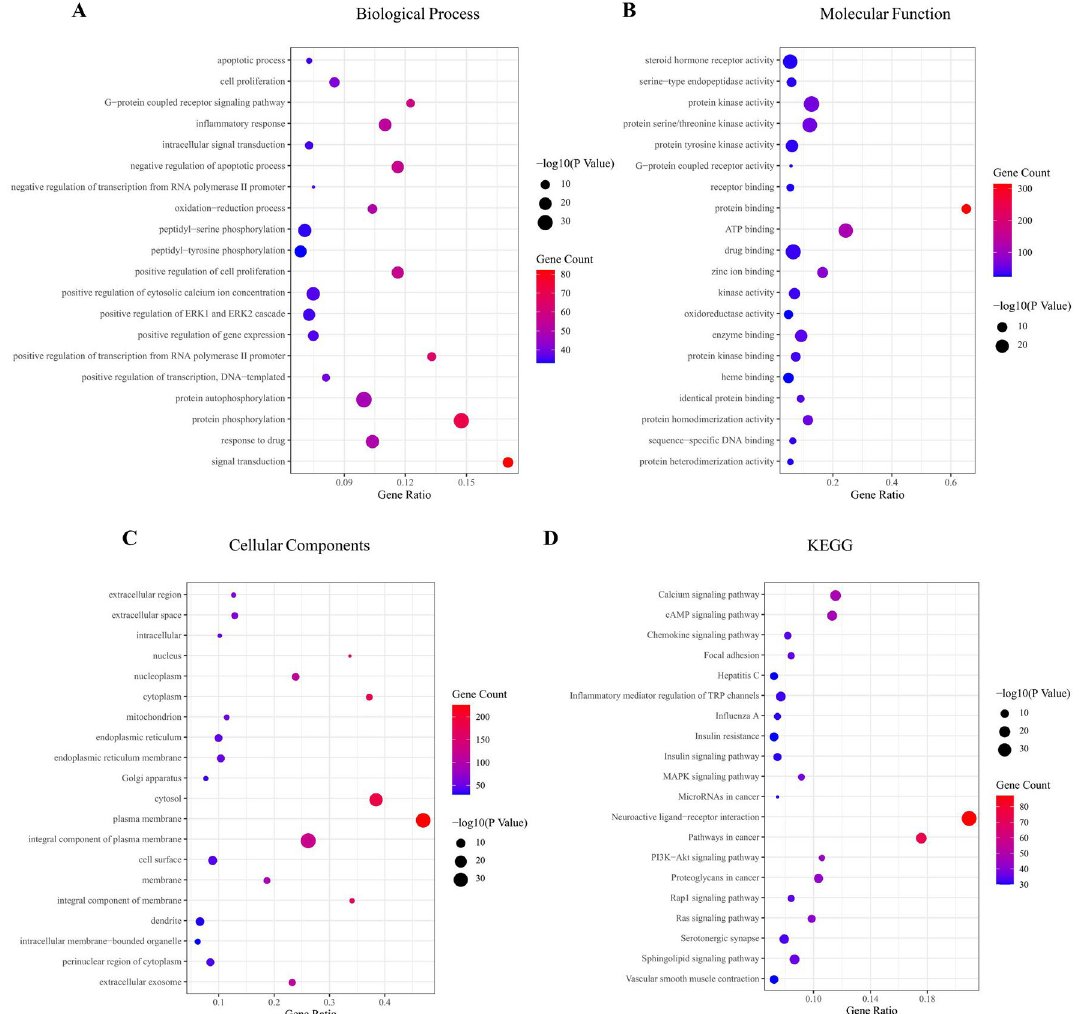
Figure 5. Bubble diagram for GO and KEGG enrichment analysis. ( A ) Biological processes for the major targets. ( B ) Molecular function for the major targets. ( C ) Cellular components for the major targets. ( D ) Represents KEGG for the major targets. The bubble size represents the number of enriched genes, and the bubble color difference represents the significant magnitude of target gene autonomously bind to the target protein. It is generally believed that the lower the energy when the conformation of ligand-receptor binding is stable, the more likely the effect will be 45 . A binding energy < − 5 kcal mol −1 indi- cates good binding activity, and a binding energy < − 7 kcal mol −1 indicates strong binding activity. The results of molecular docking were plotted as a heatmap, as shown in Fig. 7. It can be seen from the figure that cynaropicrin, 2-[(2r, 4ar, 8as)-4a-methyl-8-methyl-decalin-2-yl] acrylic acid, and eremanthin with IL6, TNF, and APP all had good activities, and the binding affinity is shown in Supplementary Table S2. The docking results of eremanthin with good activity were selected and visualized by PyMol software. In general, the calculated interactions of experimental structures of ligand–protein complexes have two different regions of high probability density. The first identifiable geometry is described by the relatively close distance between the centers of the aromatic rings (3.5–4.5 Å) between the ring plane normal vector, with a range of parameters corresponding to parallel aromatic hydrocarbon accumulation. The second dense region described by the longer distance and the near right angle of 5–6 Å corresponds to the vertical aromatic interaction 46 . In this paper, the interaction between ligands and proteins is aromatic accumulation. Eremanthin formed π–π interactions with ASN-53 (3.0 Å), ARG-25 (2.1 Å), LYS-14 (2.0 Å), TYR-18 (1.8 Å), and AGR-86 (1.9 Å) to form hydrogen bonds and with ARG-23 (3.0 Å), Glu-17 (2.7 Å), ILE-19 (1.8 Å), and THR-87 (2.5 Å) to form π–π interactions that resulted in binding to AKT1 (1UNQ) (Fig. 8A). Similarly, eremanthin was predicted to pair into the binding pocket of MAPK3 (6GES) by hydrogen bonding to LYS-224 (4.0 Å) (Fig. 8B). Eremanthin was also predicted to dock in the binding pocket of IL6 (4O9H) by 2 hydrogen bonds to TYR-34 (2.3 Å) and SER-53 (2.1 Å) (Fig. 8C). Eremanthin formed a π–π inter- action with ASP-106 (3.3 Å) through hydrogen bonding with TRP-108 (2.8 Å) in the binding pocket of MAPK1 (6OPH) (Fig. 8D). Eremanthin was in the binding pocket of EGFR (7JXP) by multiple hydrogen bonds with PHE-723 (3.4 Å), ARG-748 (3.0 Å), and GLU-749 (2.7 Å) (Fig. 8E). Eremanthin bonded to SRC (6E6E) through